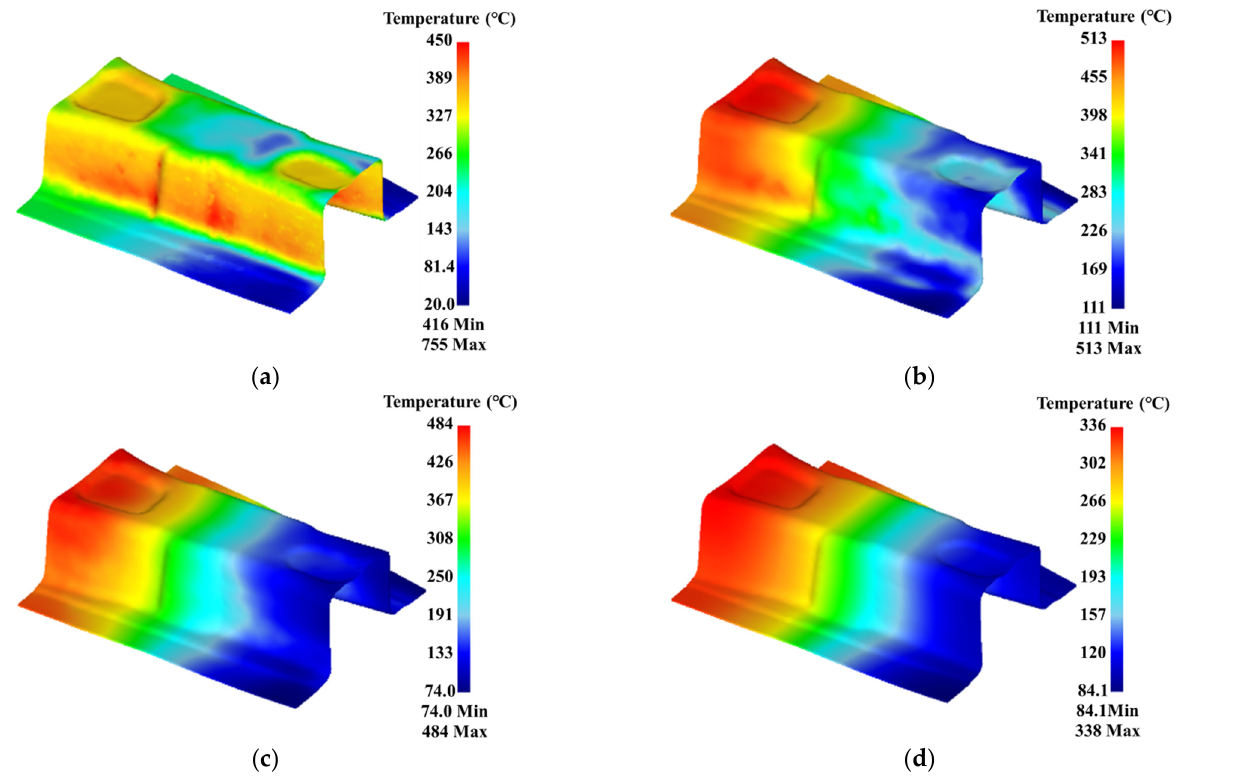
Figure 20. Temperature distribution with time for gradient region of B-pillar: ( a ) time of 14.6 s, ( b ) time of 24.6 s, ( c ) time of 34.6 s, and ( d ) time of 64.6 s.